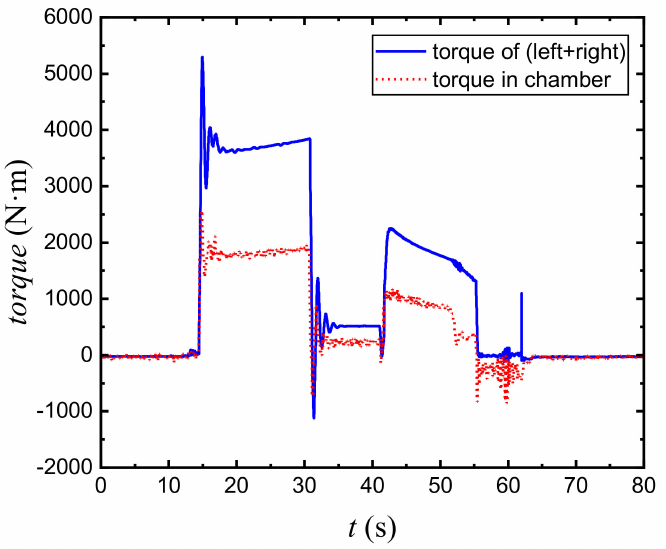
Figure 26. Comparison between the sum of the left and right end torques and the torque in the test